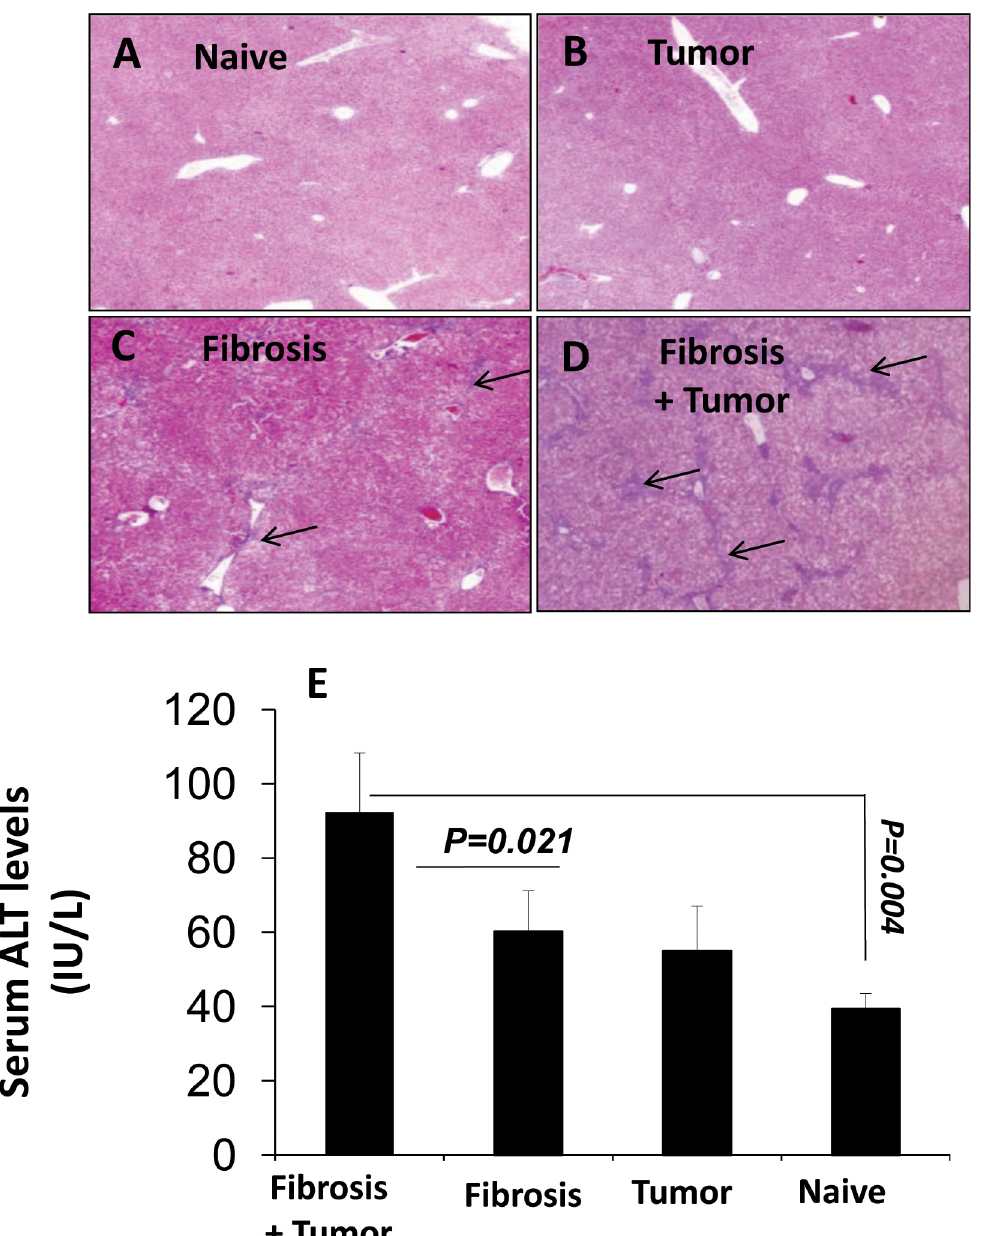
Fig 2. NPA Tumor inductions increase the severity of CCl4 related hepatic injury. CCl4-hepatic injury was evaluated by hematoxylin and eosin (H&E) staining of necro-inflammatory liver lesions and ALT serum levels. Immunohistochemical staining with H&E (5X magnification) for the four major animal groups showed necro-inflammatory lesions and cell infiltrations that were increased in the fibrotic mice receiving the NPA-tumor cells (D) as compared to fibrotic alone (C). Arrows indicate the area with lymphocyte infiltrations. No inflammatory infiltrates were seen in H&E staining of (A) na ï ve WT and (B) na ï ve mice receiving the NPA-tumor cells. (E) Serum ALT levels were in line with histological findings and showed increase from (60 ± 25/L) in fibrotic animals without tumor to (85.5 ± 20.5 U/L) in animals with tumor and hepatic fibrosis; p-value =